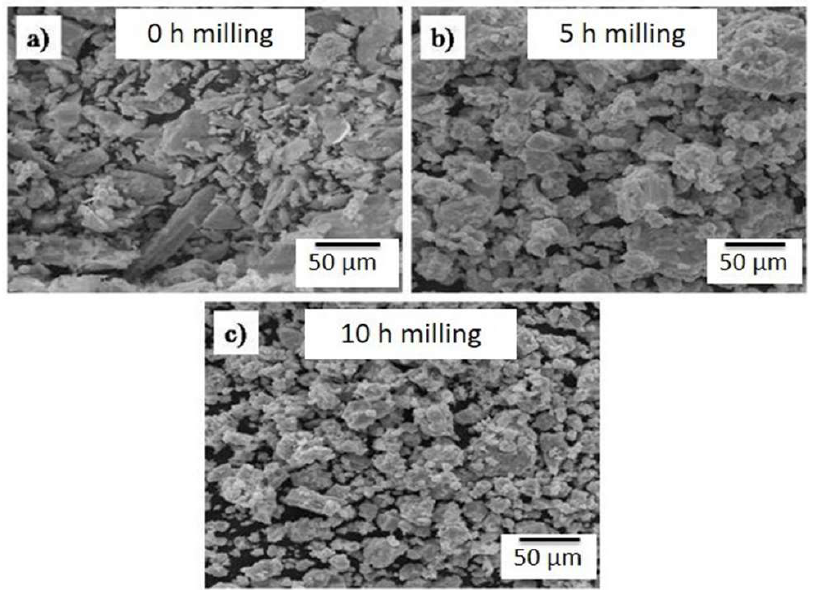
Figure 3. ( a–c ) Morphology of milled powders at regular milling interval. Figure 3. ( a – c ) Morphology of milled powders at regular milling